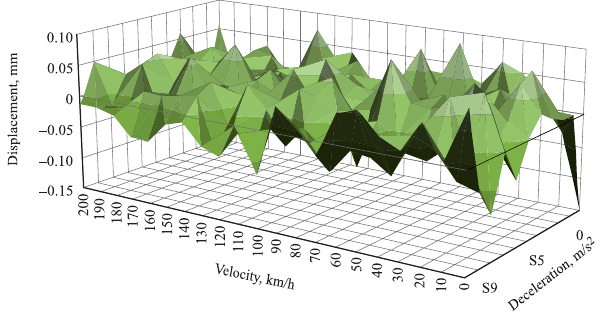
Fig. 3. Max stress of the plate with different accelerations and velocities